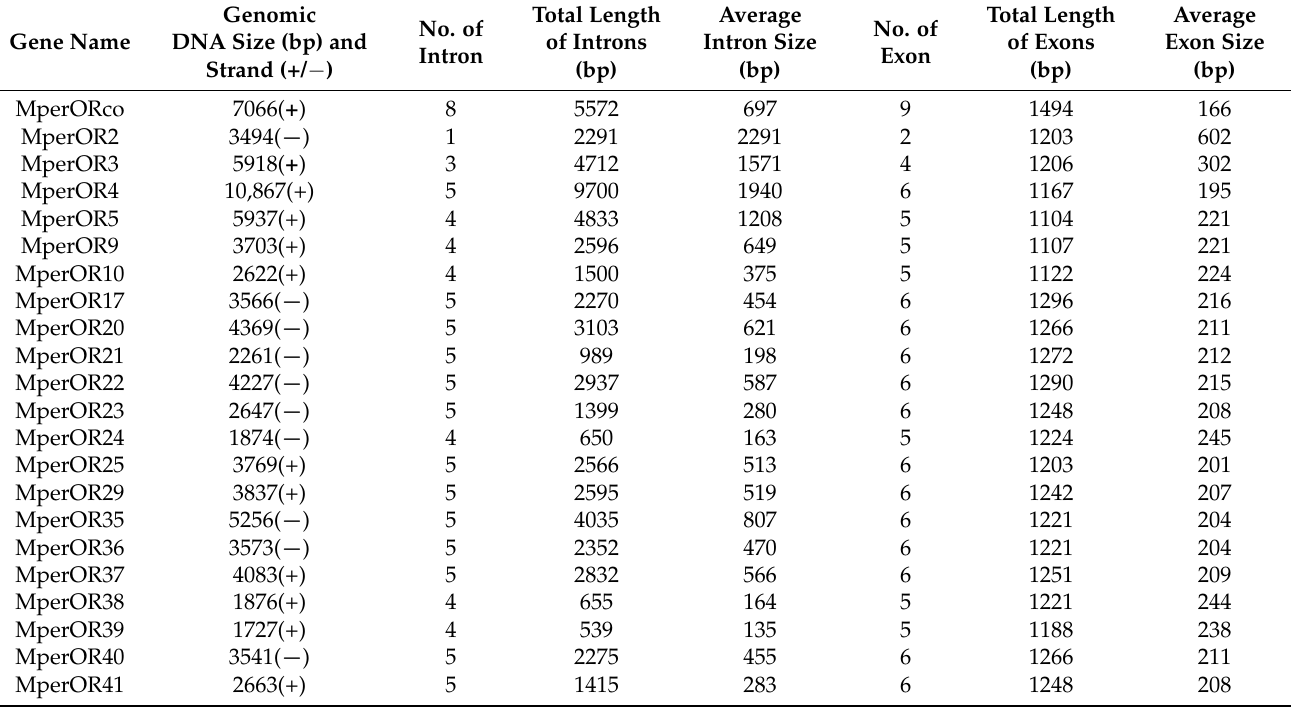
Table 2. The introns and exons of OR genes in M. persicae